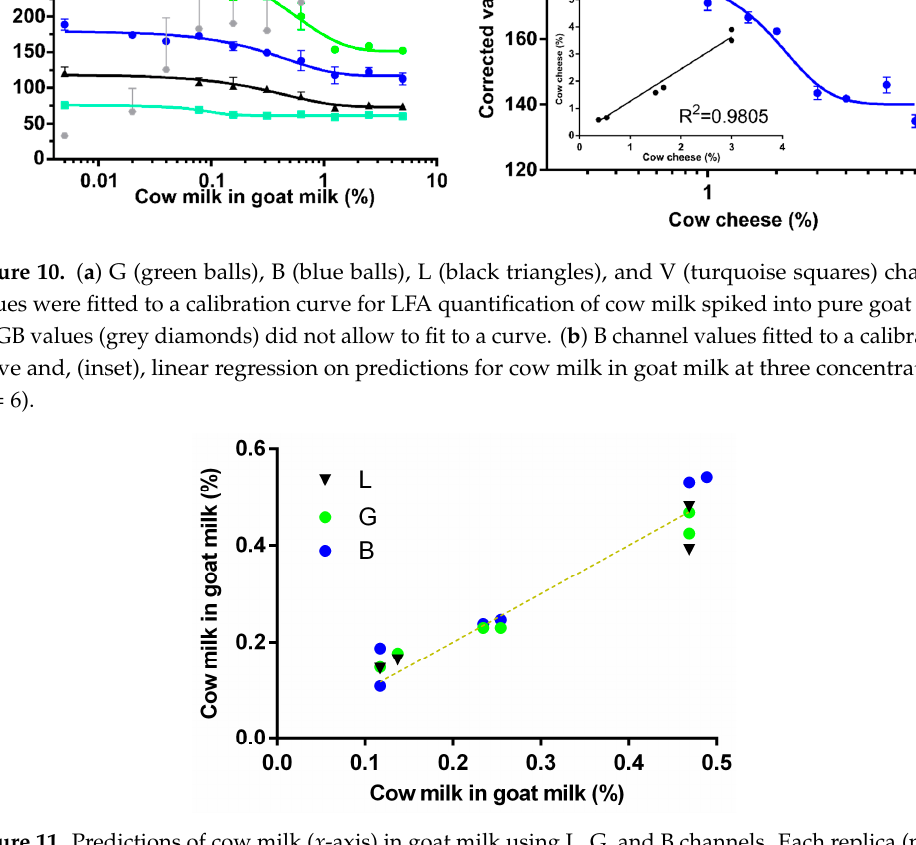
Figure 11. Predictions of cow milk ( x -axis) in goat milk using L, G, and B channels. Each replica (n = 2) is indicated. Dashed line represents a curve at 45 degrees .